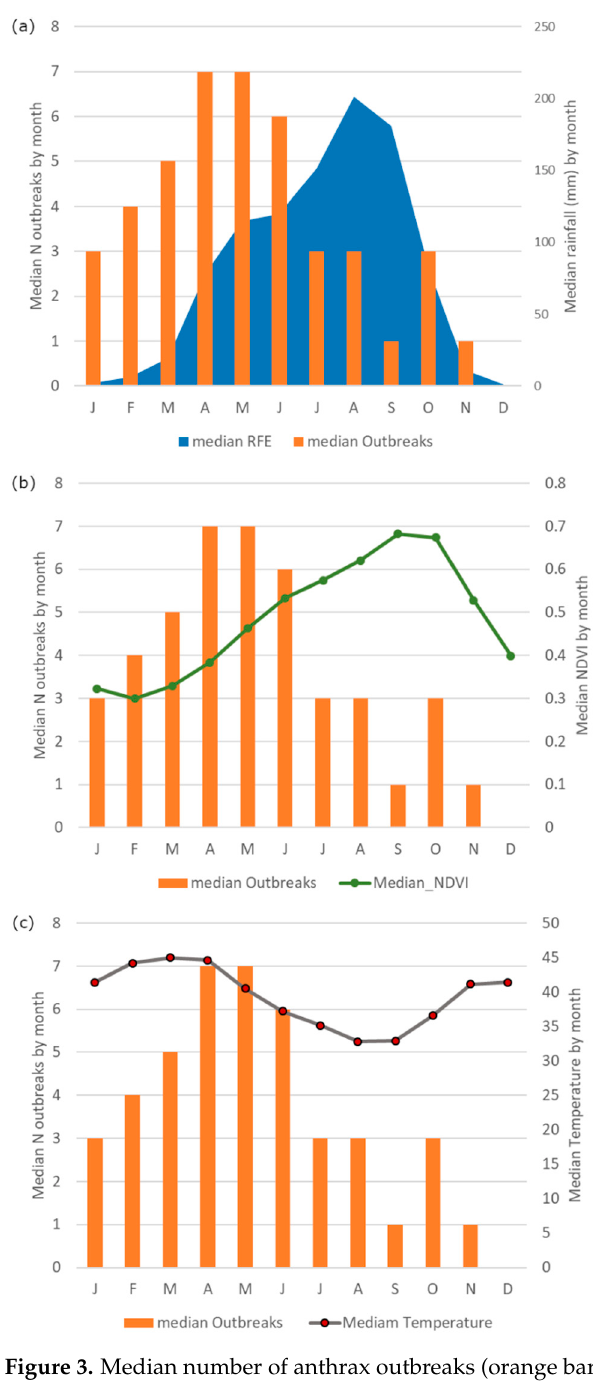
Figure 3. Median number of anthrax outbreaks (orange bar) against ( a ) median rainfall (blue area), ( b ) median NDVI (green line) and ( c ) median temperature (grey line) by month in the study area.